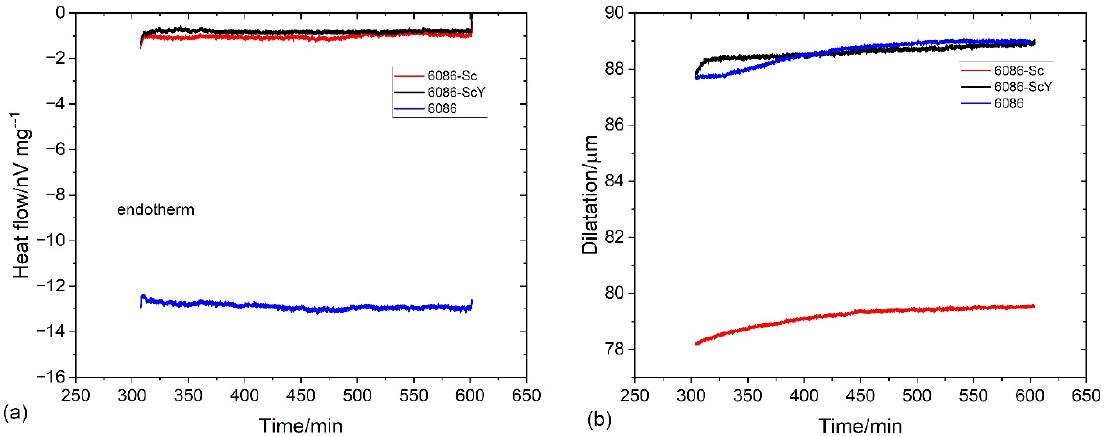
Figure 10. The XRD patterns of the investigated alloys in the homogenized condition (520 °C, 5 h) and isothermally heat-treated at 400 °C for 5 h. The most important peaks of the identified phases are indicated.